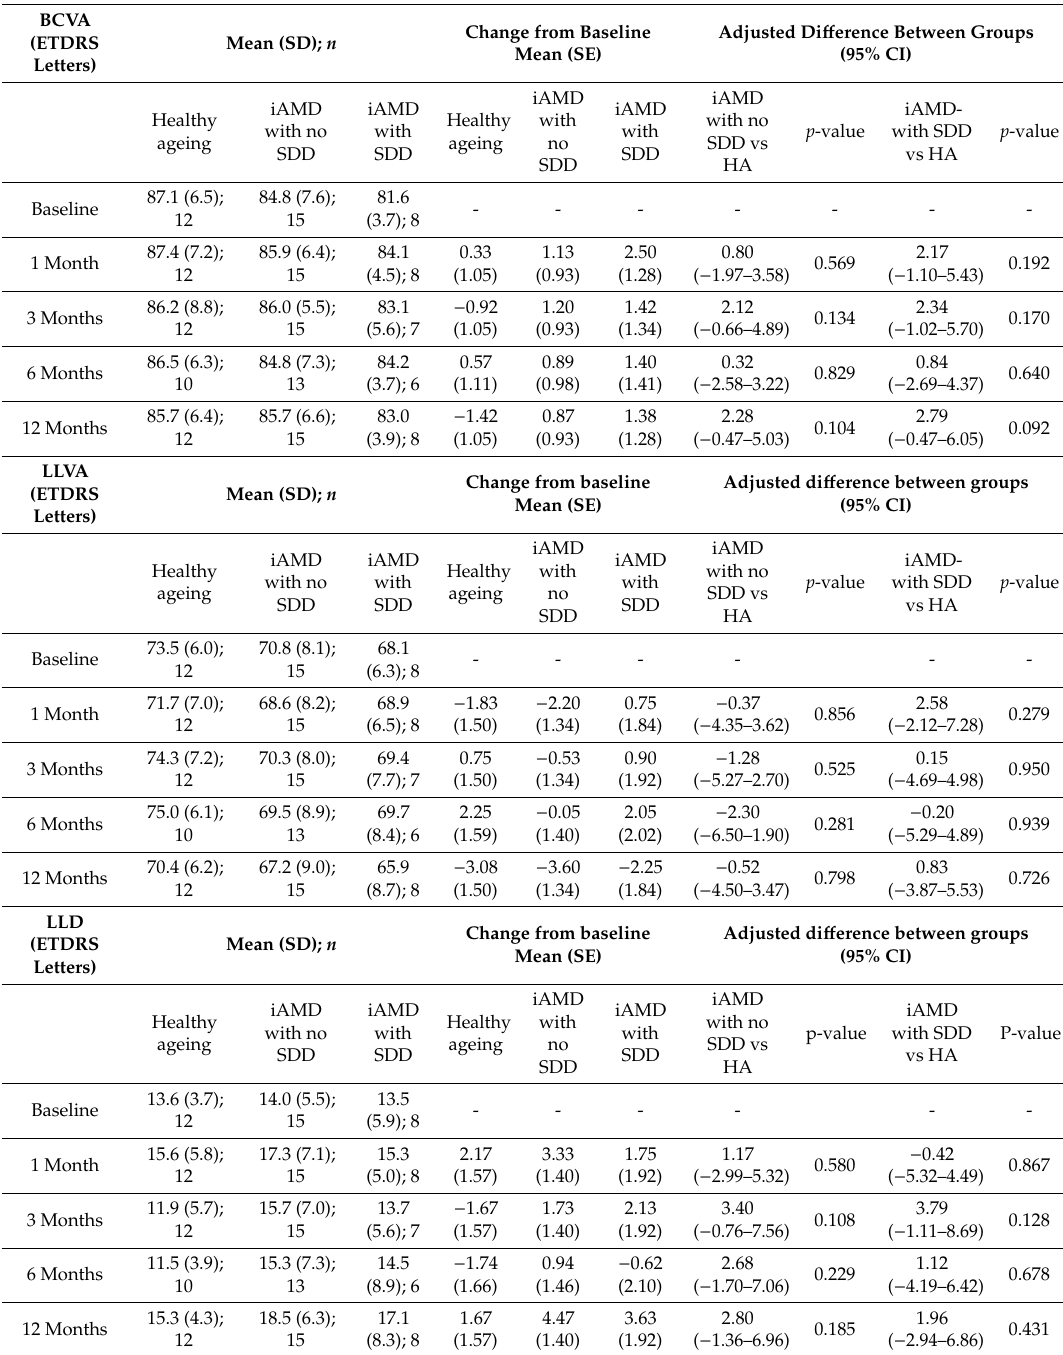
Table 3. Change in visual acuity outcomes; best-corrected visual acuity (BCVA), low-luminance visual acuity (LLVA) and low-luminance deficit